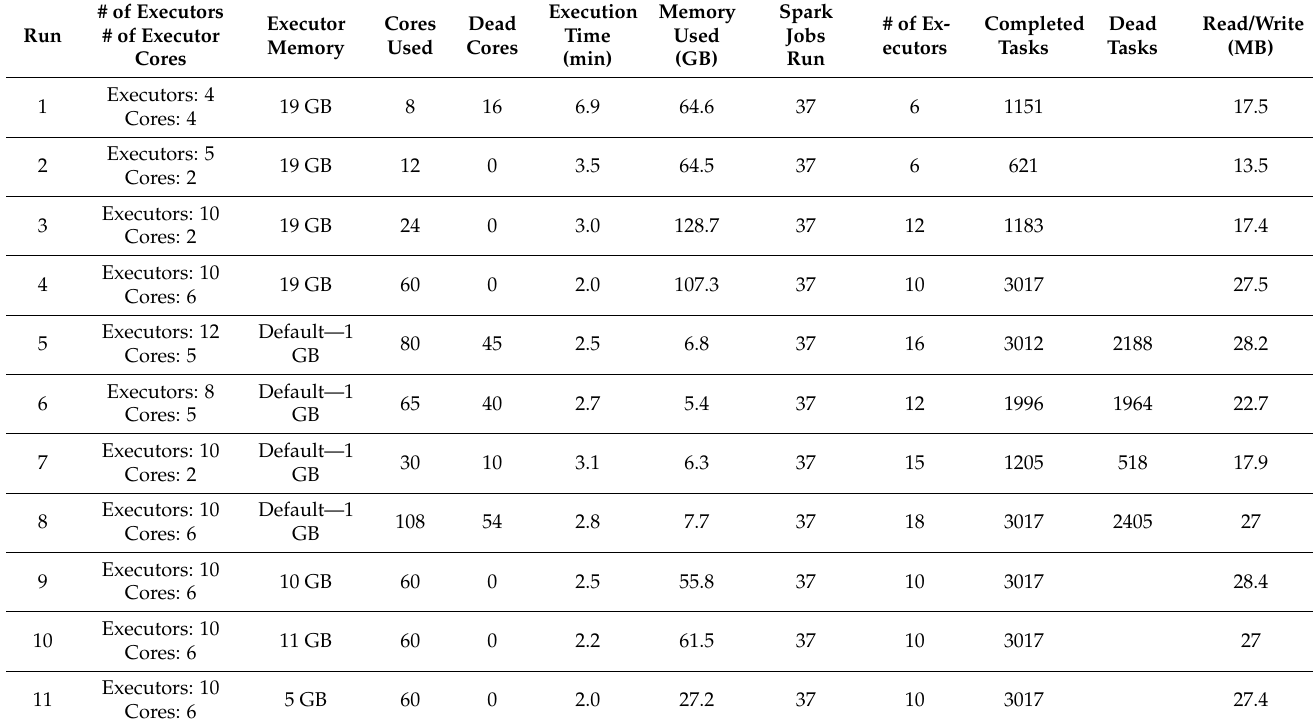
Table 2. All Trial Runs.